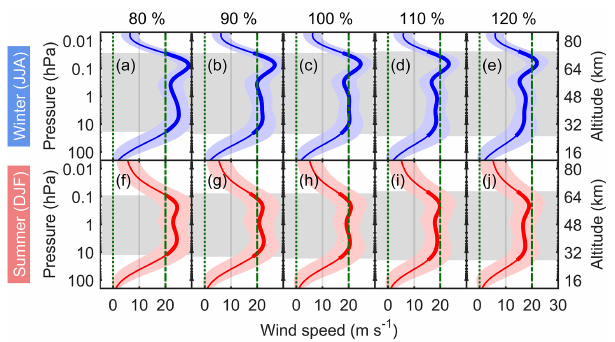
Figure 6. Monte Carlo error analyses using 500 repeat zonal wind retrievals for simulated clear-sky, 12h observations (i.e. 6h in east and 6h in west directions) of the O 3 231.28GHz line using a ground-based radiometer with a 1400K system temperature, 30kHz frequency resolution, and 60 ◦ zenith viewing angle located at Hal- ley station (75 ◦ 37 (cid:48) S, 26 ◦ 14 (cid:48) W), Antarctica. The a priori O 3 VMR profiles are scaled by 80, 90, 100, 110, and 120% of the “true” pro- files for (a) – (e) , and (f) – (j) respectively. The mean retrieved winter and summer winds and 1 σ errors (shaded areas) are shown, with the thicker sections and the shaded grey panels indicating where MR ≥ 0.8. The true wind profile used to simulate the atmospheric spectra is shown by the dash-dotted green lines. The a priori wind profile is shown by the dotted green